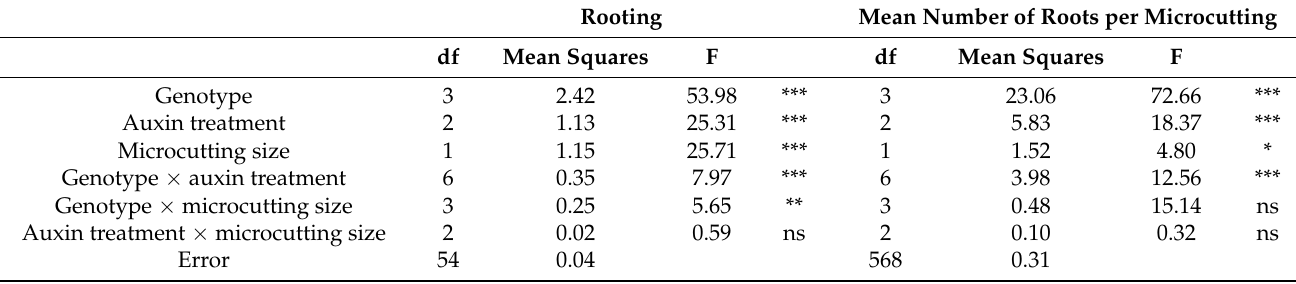
Table 3. Effect of different factors (genotype, auxin treatment and microcutting size) on rooting of Sorbus species used in our